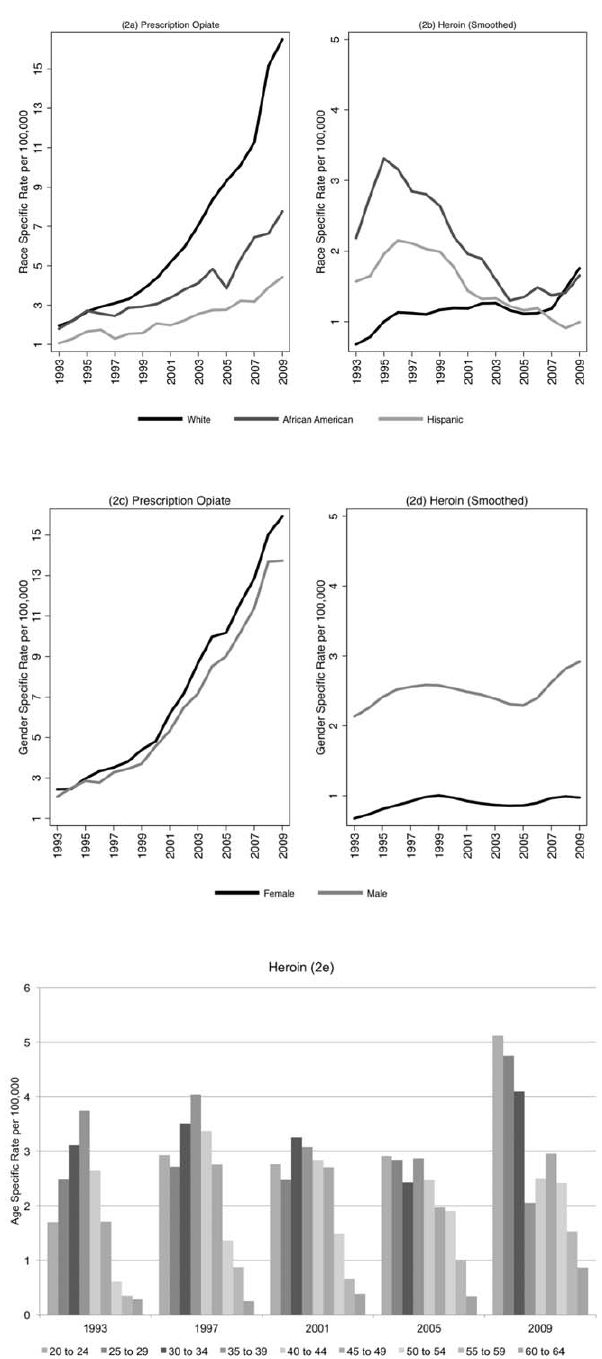
Figure 2. Demographic trends. doi:10.1371/journal.pone.0054496.g002 PODs, holding other variables constant. The relationship between the lagged HOD and current year PODs is 40% (p , 0.001) weaker in urban hospitals compared with rural hospitals. The HOD model uses a one year lagged count of hospital POD, urbanicity of the hospital and interaction between urbanicity and POD, while controlling for the a one year lagged count of HOD and secular trends using a time coefficient. This model suggests that there is a strong relationship between PODs and HODs.